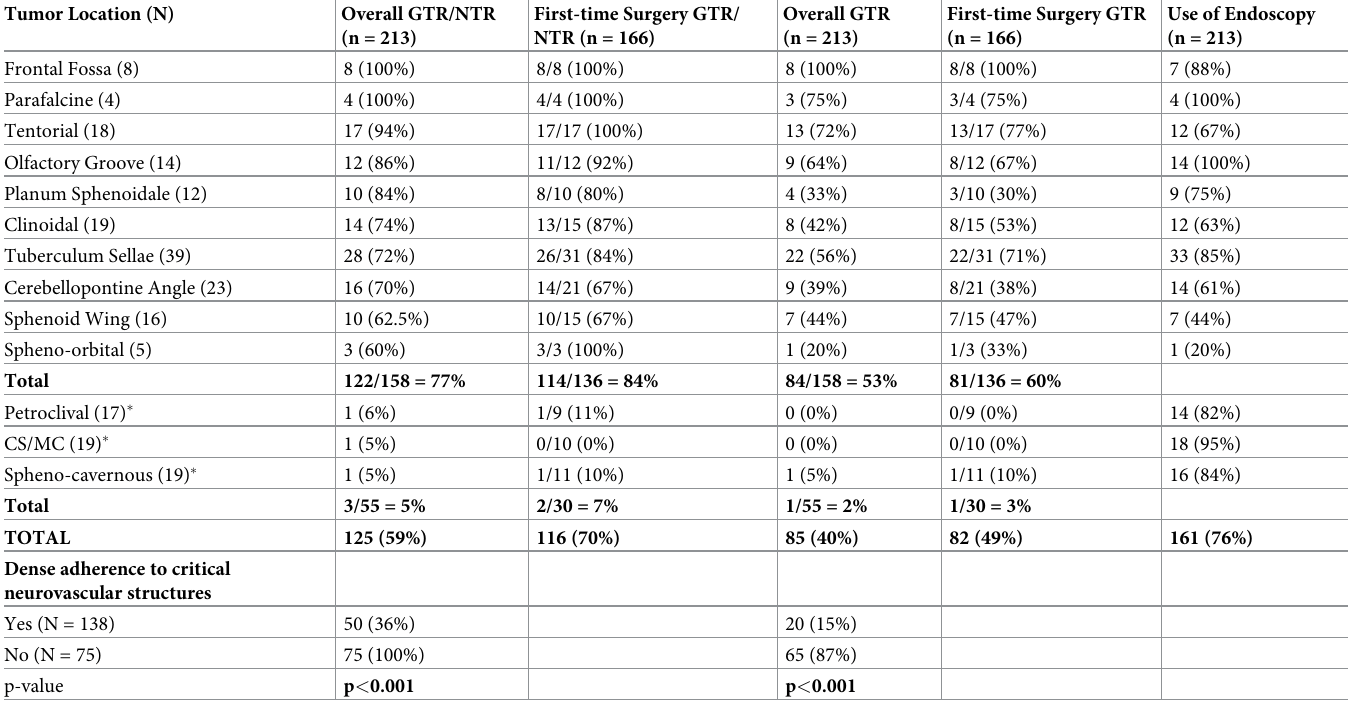
Table 3. Resection rates in 213 keyhole approaches by meningioma location, invasiveness & use of endoscopy.